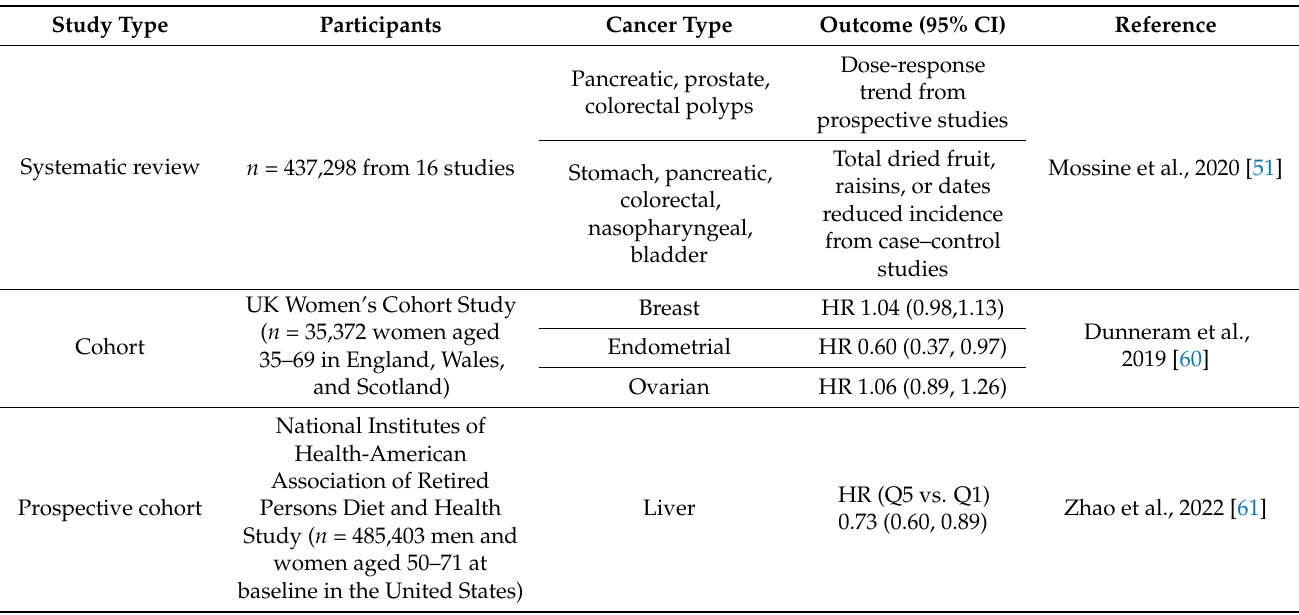
Table 1. Epidemiological studies assessing the association between dried fruit intake and cancer risk published since